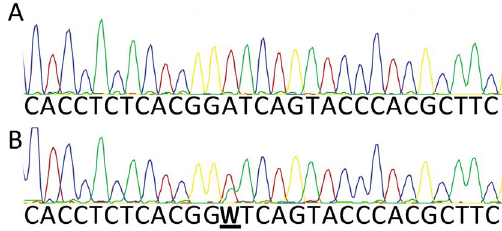
Figure 7. Synthetic MEST template mixing experiments using marked templates. PCR with primers MESTPF1/MESTPR3C or MESTPF1A/MESTPR3C on the two gBlock constructs (wild-type and mutant) generated synthetic templates that were identical except for the presence of one variant base introduced with the mismatch primer MESTPF1A. Methylated and unmethylated forms of these amplicons were diluted and mixed, subjected to PCR, and then genotyped by Sanger sequencing. Products derived from the synthetic templates could be distinguished due to the presence of either an A or T at this position. (A) wild-type templates for which the ‘‘T’’ allele was methylated, and the ‘‘A’’ allele was unmethylated, showing apparent ‘‘A’’ homozygosity; (B) mutant (non-G4 forming) templates for which the ‘‘T’’ allele was methylated, and the ‘‘A’’ allele was unmethylated, showing apparent heterozygosity